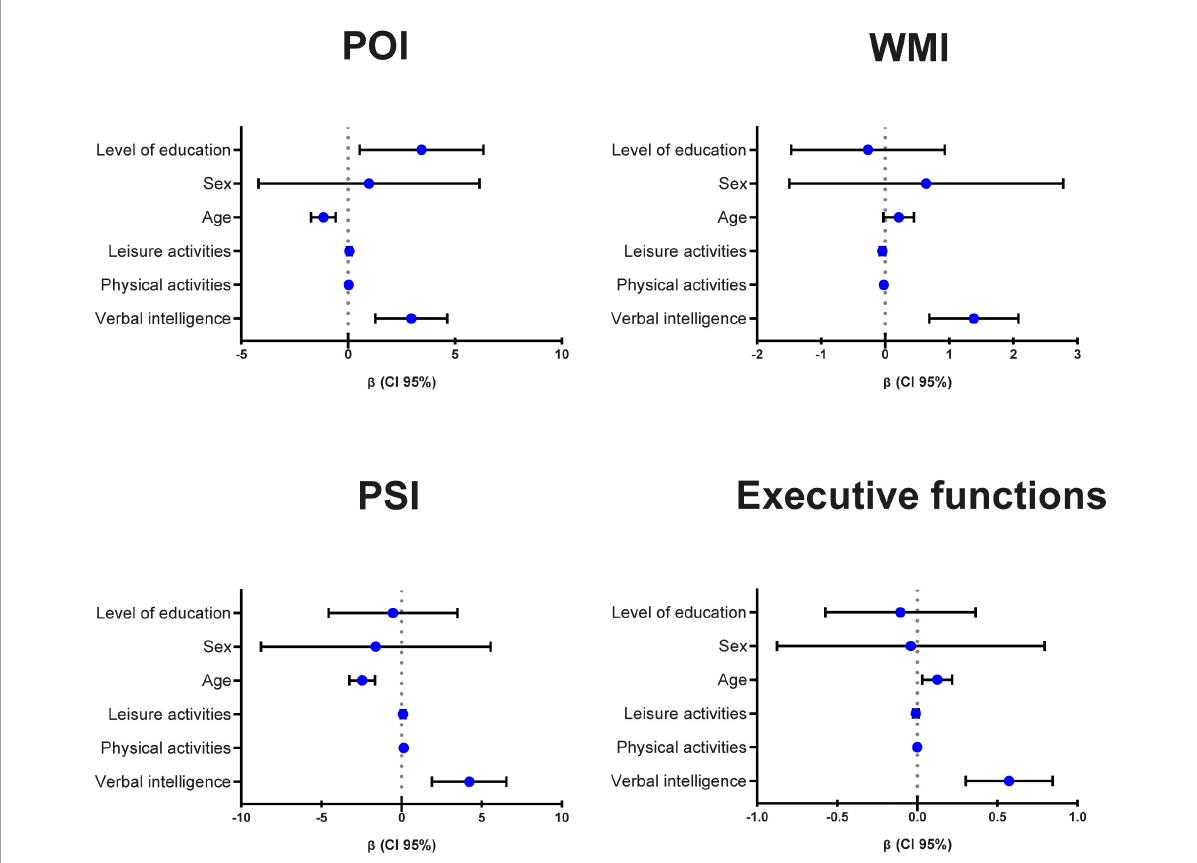
FIGURE1 Visual summary of the statistically significant (Bonferroni corrected: p < 0.007) multiple linear regressions for cognitive performance. POI, Perceptual Organization Index; WMI, Working Memory Index; PSI, Processing Speed Index; CI, confidence